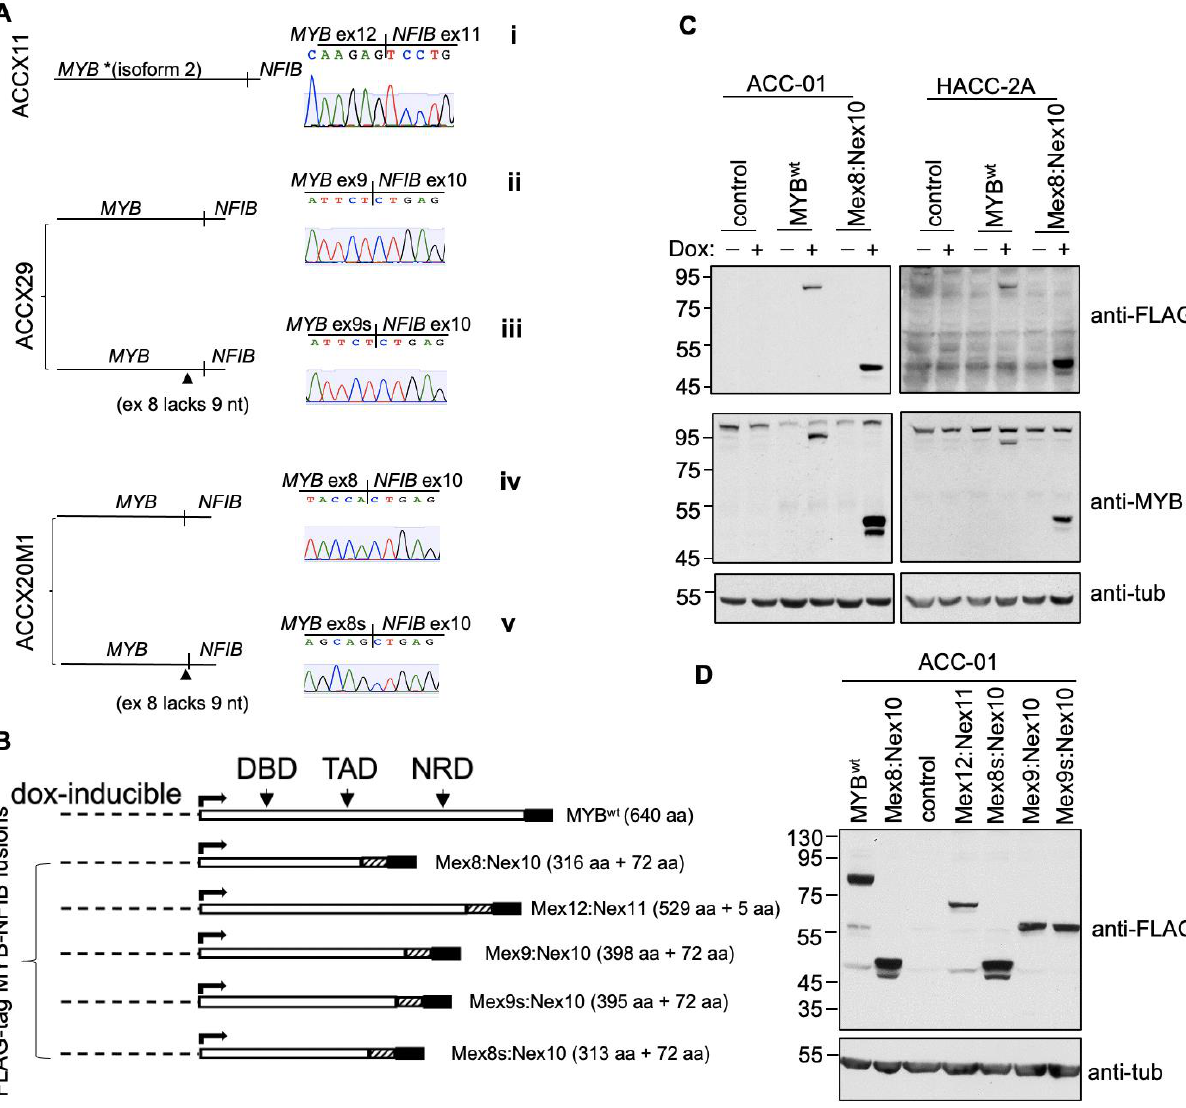
Figure 3. Expression and characterization of MYB-NFIB fusion. ( A ), Sequencing chromatogram showing MYB-NFIB fusion junctions as derived from three ACCXs. Two variants of MYB-NFIB fusion were detected in ACCX29 (ii and iii) and ACCX20M1 (iv and v) with its second form (iii and v) representing a variant lacking 9 nucleotides on MYB exon 8. * Note that in MYB-NFIB fusion from ACCX11 (i), MYB region represent isoform 2 as sequencing revealed the lack of exon 10 normally present in the larger isoform 1. ( B ), Schematic representation of dox-inducible FLAG-tagged MYB wt and MYB-NFIB fusion constructs. Striped and shaded box represents the position of NFIB and FLAG-tag, respectively. DBD: DNA binding domain; TAD transactivation domain; NRD: negative regulatory domain. ( C ), Immunoblotting analysis of MYB wt and MYB-NFIB fusion expression in ACC-01 and HACC-2A cells following dox induction. Complementary antibodies (anti-FLAG and N-terminal epitope anti-MYB) were used to verify the expression. ( D ), ACC-01 cells expressing the various MYB-NFIB fusion variants were verified by immunoblotting with anti-FLAG. In A, B and D, the ”s” represent the absence of 9